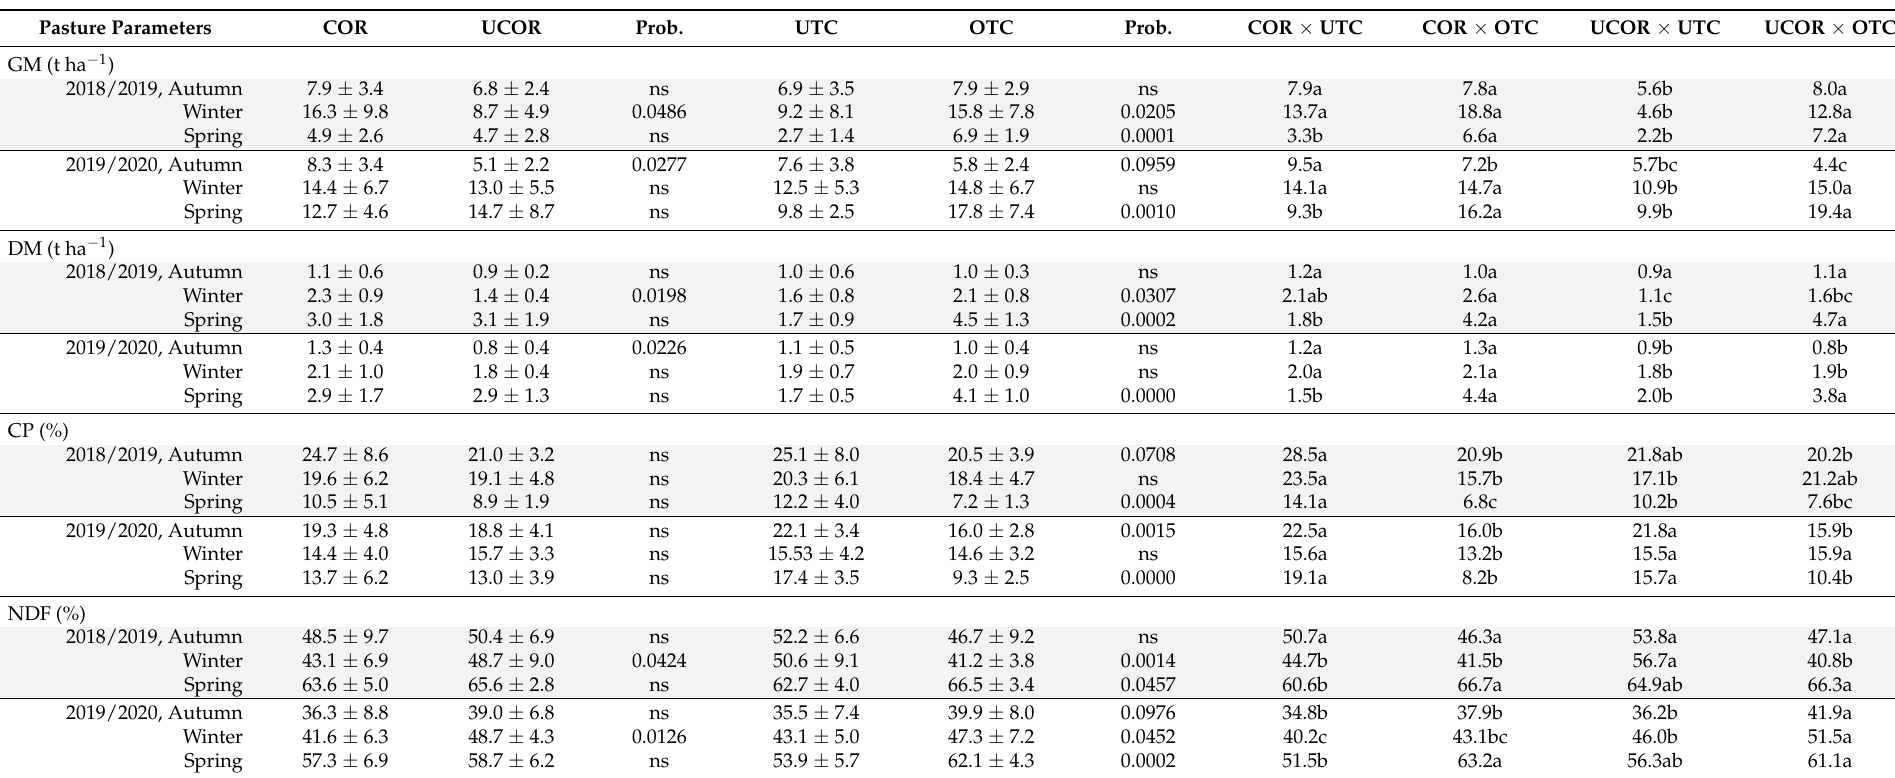
Table 2. Descriptive (mean ± standard deviation) and inferential statistics of pasture parameters of the experimental field. Pasture